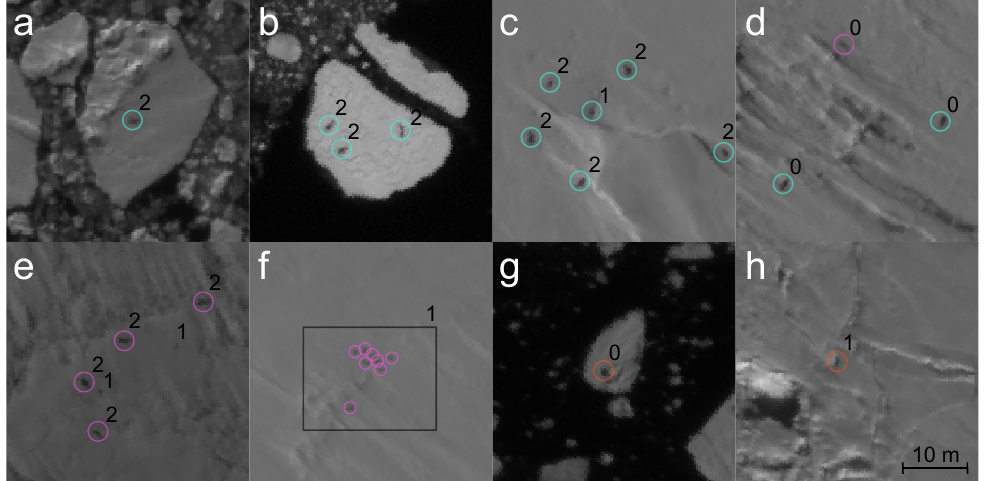
Figure 7. Prediction samples from our best ensemble model on eight scenes from the random crops test set. Samples were chosen to represent scenarios where the model predicts seal locations correctly (panels a – d ), fails to find existing seals (panels d – f ), and annotates background objects as seals (panels g , h ). Seals marked with teal circles indicate true positives (i.e., predicted seal present in consensus dataset), whereas purple and orange circles indicate false-negative and false-positive seals, respectively. Numbers next to circle annotations indicate the number of human observers that agreed with that particular model annotation. Number ‘1’ annotations unaccompanied by circles in panel e indicate edge cases where a human observer annotated a seal that was not present in the consensus dataset or model predictions. Imagery copyright Maxar Technologies Inc.